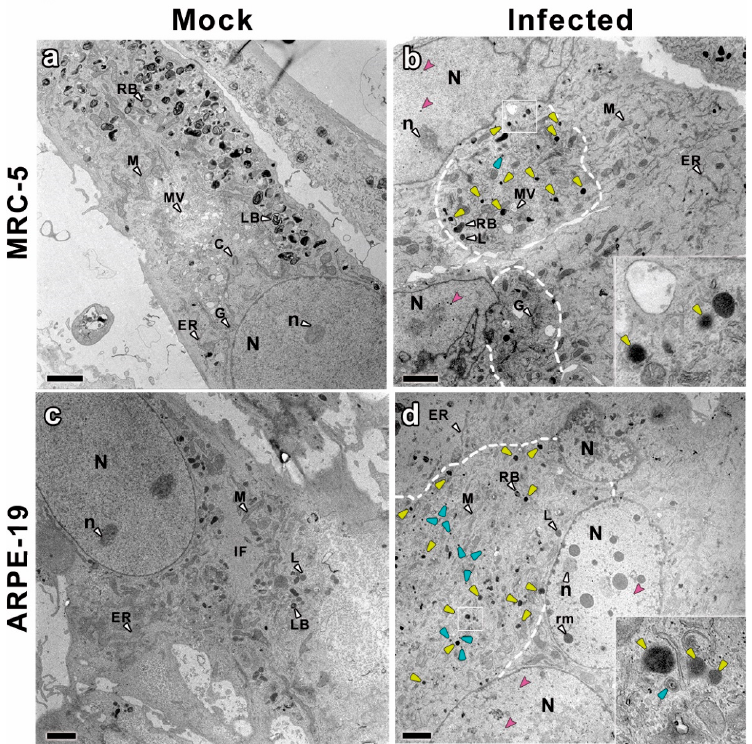
Figure 2. Electron microscopy images of epoxi-embedded sections of MRC-5 and ARPE-19 cells, mock and infectedsamples. ( a ) MRC-5 mock infected cells; ( b ) MRC-5 infected cells; ( c ) ARPE-19 mock-infected cells; ( d ) ARPE-19 infected cells. CI (dashed lines) alterations are observed in both infected cell types: more electron dense areas where there is an accumulation of components of the cellular secretory apparatus and structures compatible with DB (yellow arrowheads), along with viral particles (blue arrowheads). In the inset images, higher magnification of specific areas, labeled with squares, show structures compatible with DB, along with Golgi-like elements and viral particles. ARPE-19-infected cells show the formation of syncytia, multinucleated cells resulted from multiple cell fusions during the infection. Some of these nuclei exhibit multiple very electron dense round masses, associated at their periphery with viral capsids (pink arrowheads), and areas of electron opacity in contact with the nuclear membrane. Other cellular organelles and cellular structures are indicated with letters and white arrowheads: N––nucleus, n––nucleolus, rm––electron dense round masses inside the nucleus, L––liposomes, LB––lamellar bodies, RB––residual bodies, MV––multivesicular bodies, M––mitochondria, ER––endoplasmic reticulum, G––Golgi apparatus, IF––intermediate filaments. Bars: 2 microns.